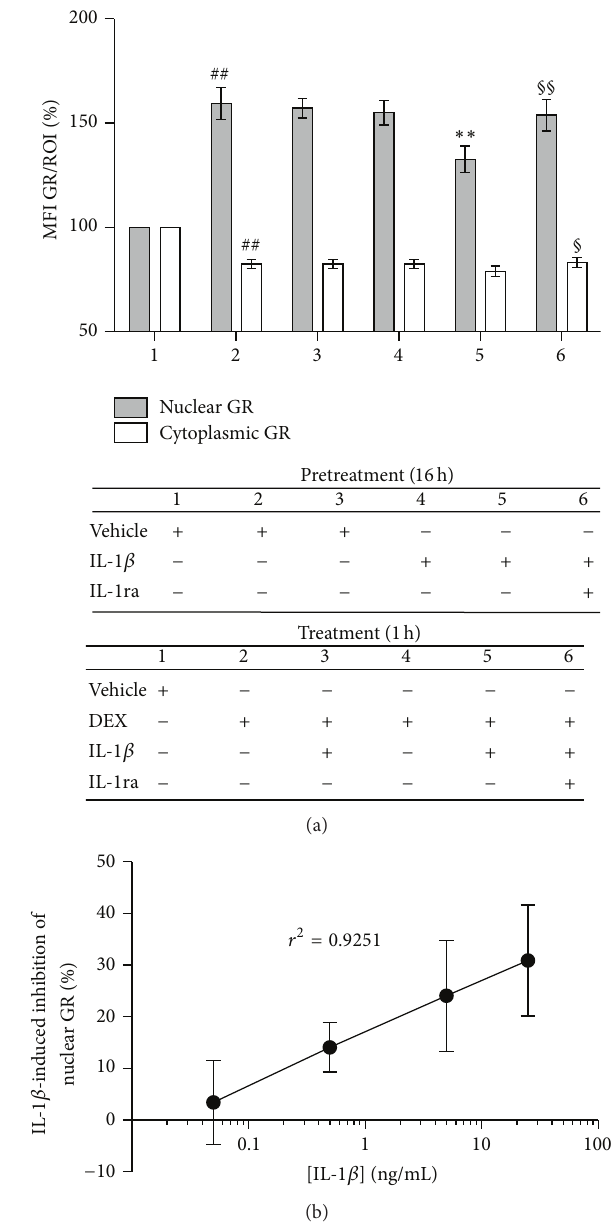
Figure 1: Sustained IL-1 𝛽 conditions reduce DEX-driven nuclear GR translocation in a dose-dependent manner, mediated by IL-1R1. Cells were pretreated with either vehicle (veh) or 5 ng/mL IL-1 𝛽 for 16h and then treated for 1h with either veh, 10 −8 M DEX or 5 ng/mL IL- 1 𝛽 + 10 −8 M DEX, in the absence or presence of 1 𝜇 g/mL IL-1ra, as detailed in the table below the histogram. After culture, the cells were fixed, permeabilized, and stained with 𝛽 -actin- and GR-specific antibodies. They were then labeled with secondary fluorescent antibodies and DAPI, mounted, and subjected to HCA three-color fluorescence microscopy. 𝛽 -actin and DAPI staining were used to demarcate the cytoplasmic and nuclear regions of interest (ROI), respectively. (a) Histogram bars represent the HCA results for each culture condition, numbered 1–6. Changes in the levels of nuclear (gray column) and cytoplasmic (white column) GR are expressed as % mean fluorescence intensity (MFI)/nuclear or cytoplasmic ROI ± SD ( 𝑛 = 5 ), relative to GR content in vehicle-treated cells, which are set as 100%. ## 𝑃 < 0.005 , differences in either nuclear or cytoplasmic GR between veh/DEX-treated (a2) and veh/veh-treated cells (a1). ∗∗ 𝑃 < 0.005 , difference in nuclear GR between IL-1 𝛽 /IL-1 𝛽 + DEX-treated (a5) and DEX-treated cells (a2). §§ 𝑃 < 0.005 and § 𝑃 < 0.05 , differences between IL-1 𝛽 + IL-1ra/IL-1 𝛽 + IL-1ra + DEX-treated (a6) and IL-1 𝛽 /IL-1 𝛽 + DEX-treated cells (a5) in their nuclear or cytoplasmic GR level, respectively. (b) Dose-dependent inhibition of nuclear GR translocation was assayed in cells pretreated with titrated concentrations of IL-1 𝛽 (50 pg/mL to 25 ng/mL) for 16 h and then treated for 1 h with the corresponding IL-1 𝛽 concentration +10 −8 M DEX. The results show the mean percentage of inhibition of GR nuclear translocation observed under sustained IL-1 𝛽 conditions, compared to veh/10 −8 M DEX-alone conditions and their 95% confidence